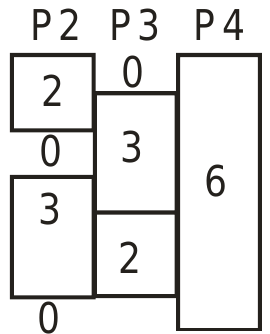
Fig. 7. LB scheme (numbers refer to minutes, P i refers to processor i